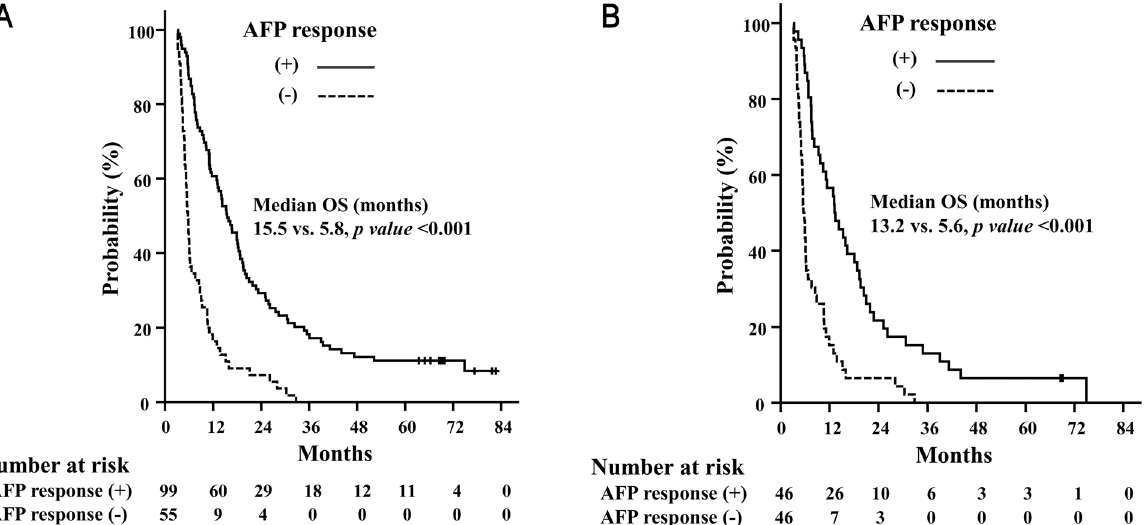
Fig 2. Overall survival rates. Overall survival (OS) rates depending on the AFP response in all patients (A) and in the propensity score-matching cohort (B).